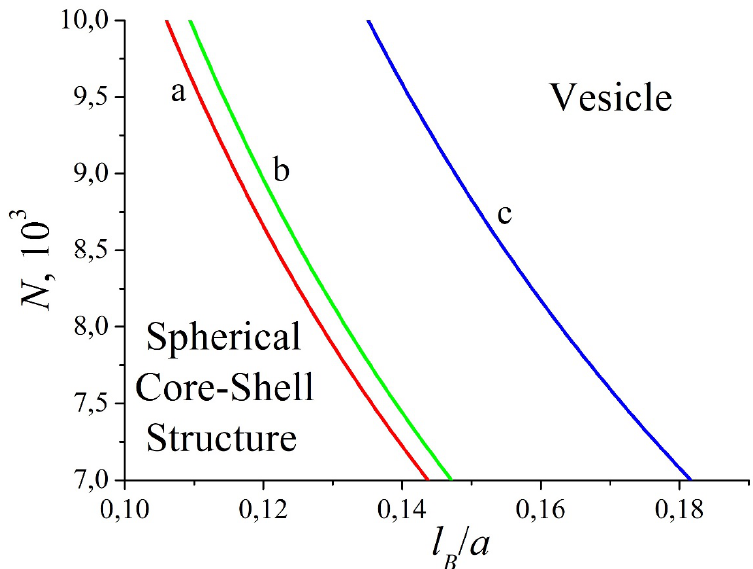
Figure 10. The morphological diagram of the complex in the coordinates “polymerization degree–Bjerrum length” for different degrees of ionization and second virial coefficients: f = 0.5, B / υ H = 3 ( a ); f = 0.5, B / υ H = 4 ( b ); f = 0.45, B / υ H = 4 ( c ). Other parameters: υ H / υ S = 1, χ = 6, υ H / a 3